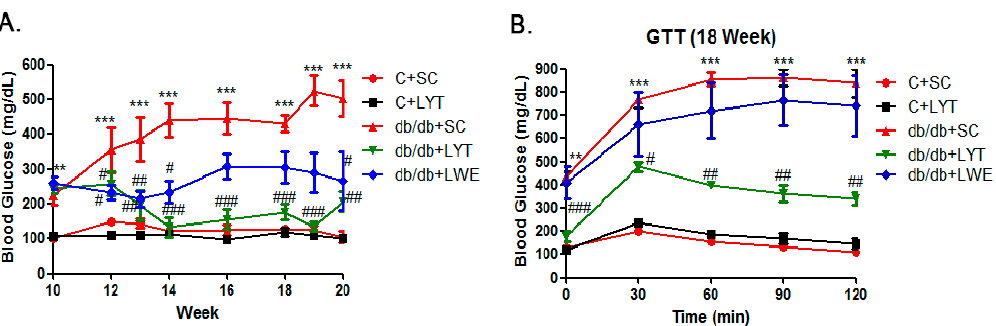
Figure 3. Blood glucose ( A ) and glucose tolerance test ( B ) in five group of mice. Values are means ± SE ( n = 4–6). ** p < 0.01; *** p < 0.001 when compared with the C + SC group; # p < 0.05; ## p < 0.01; ### p < 0.001 when compared with the db/db + SC group.